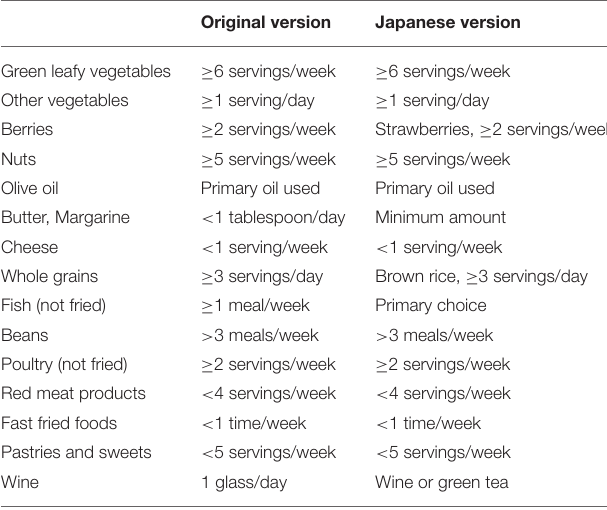
TABLE 1 | Original and Japanese-modified version of the MIND